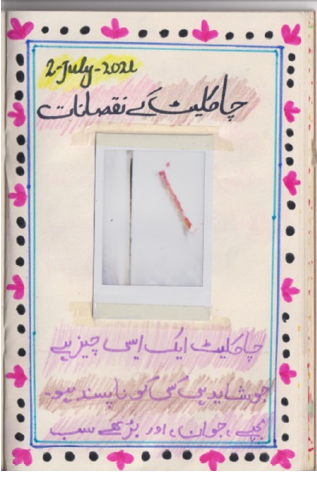
Figure 2. Ashi’s photodiary: “adverse effects of chocolate. Chocolate is something that hardly anyone dislikes. Kids, adults and elderly all like [continues on another page, not shown] to eat chocolate. Although it is delicious in taste, it has adverse effects